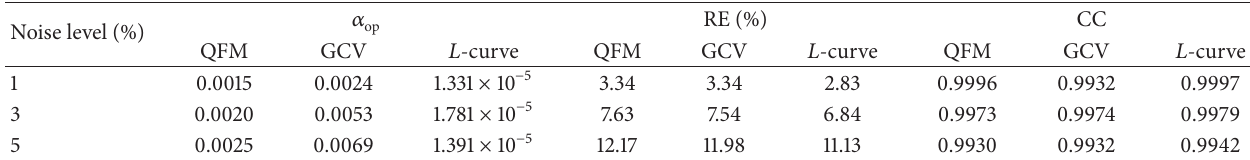
Table 1: Relative results of identified AM load of SISO system.